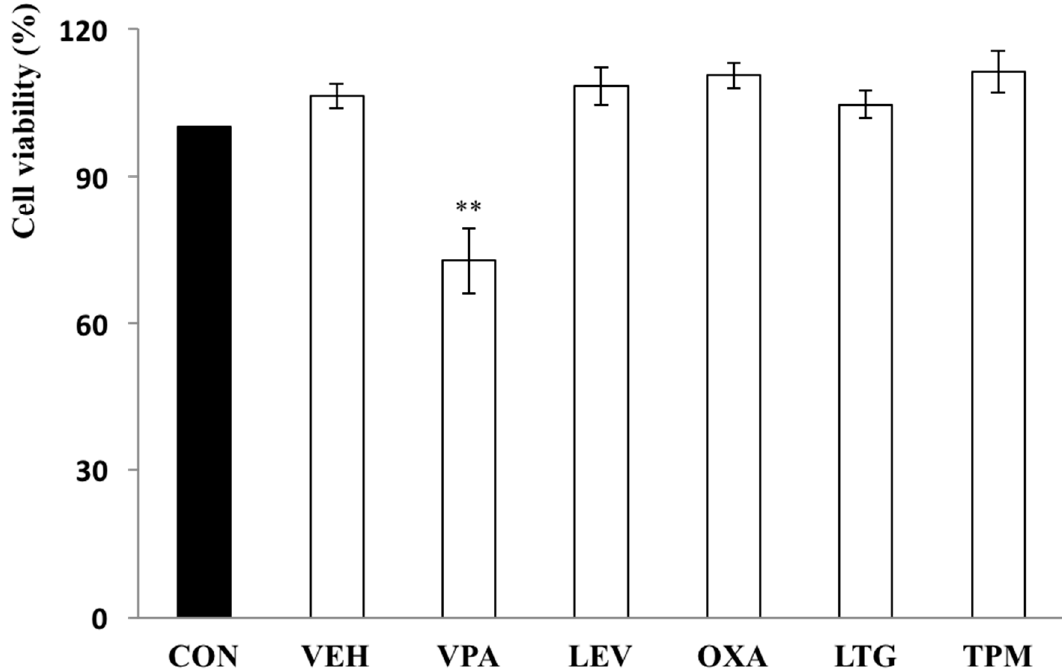
Figure 1. VPA significantly inhibits the proliferation of rat growth plate chondrocytes.Rat growth plate chondrocytes were treated daily with 60 µ g / mL VPA, 7 µ g / mL OXA, 37 µ g / mL LEV, 5 µ g / mL LTG, or 10 µ g / mL TPM for 5 days. The proliferation of the chondrocytes was assessed by the MTT assay. Among the AEDs tested, rat chondrocytes significantly decreased 72.65 ± 6.68% in the VPA group ( p = 0.0064) ( n = 5, ** p < 0.01, compared with control). CON—control, culture medium; VEH—